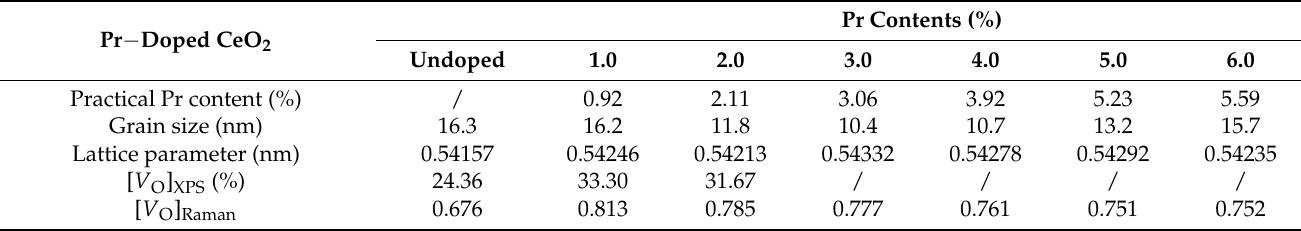
Table 1. Practical Pr contents, grain size, lattice parameters and [ V O ] XPS and [ V O ] XPS of Undoped CeO 2 and Pr-doped CeO 2 with different Pr contents synthesized by solvothermal method at 200 ◦ C for 24 h followed by calcination in air at 500 ◦ C for 2